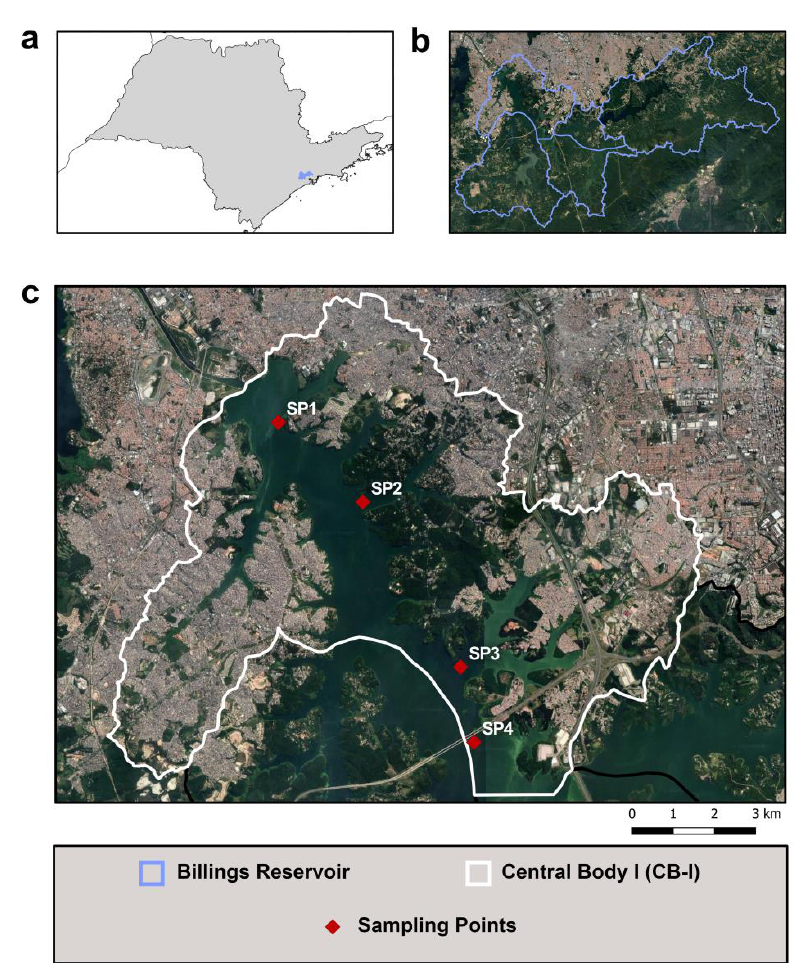
Figure 1. Location and sampling points of Billings Reservoir. ( a ) State of São Paulo, Billings Reservoir in blue. ( b ) Billings Reservoir subdivided into five compartments as per Brazilian regulation. ( c ) Central Body-I, sampling points in red.